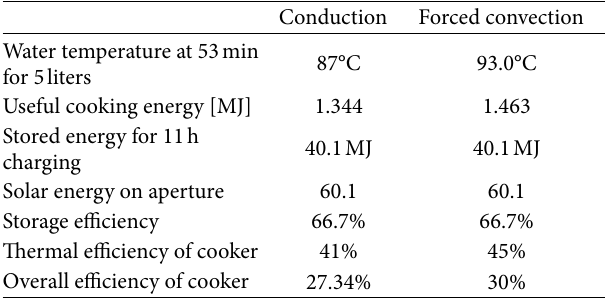
Table 7: Efficiency for the condition of highest DNI.